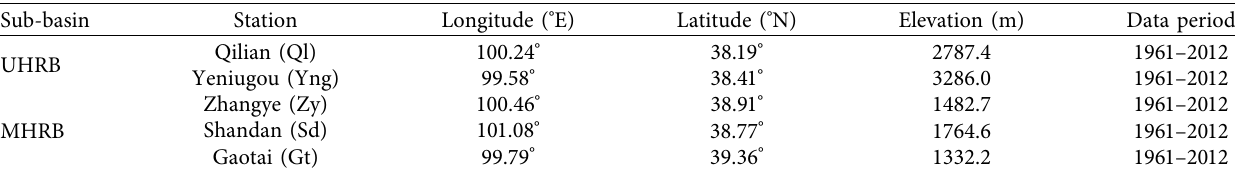
Figure 1: The upstream and midstream in the Heihe River Basin with meteorological and hydrological stations and digital elevation map (a), land use and land cover (LULC) in 2011 (b), and vegetation types (c). Table 1: Information on the meteorological